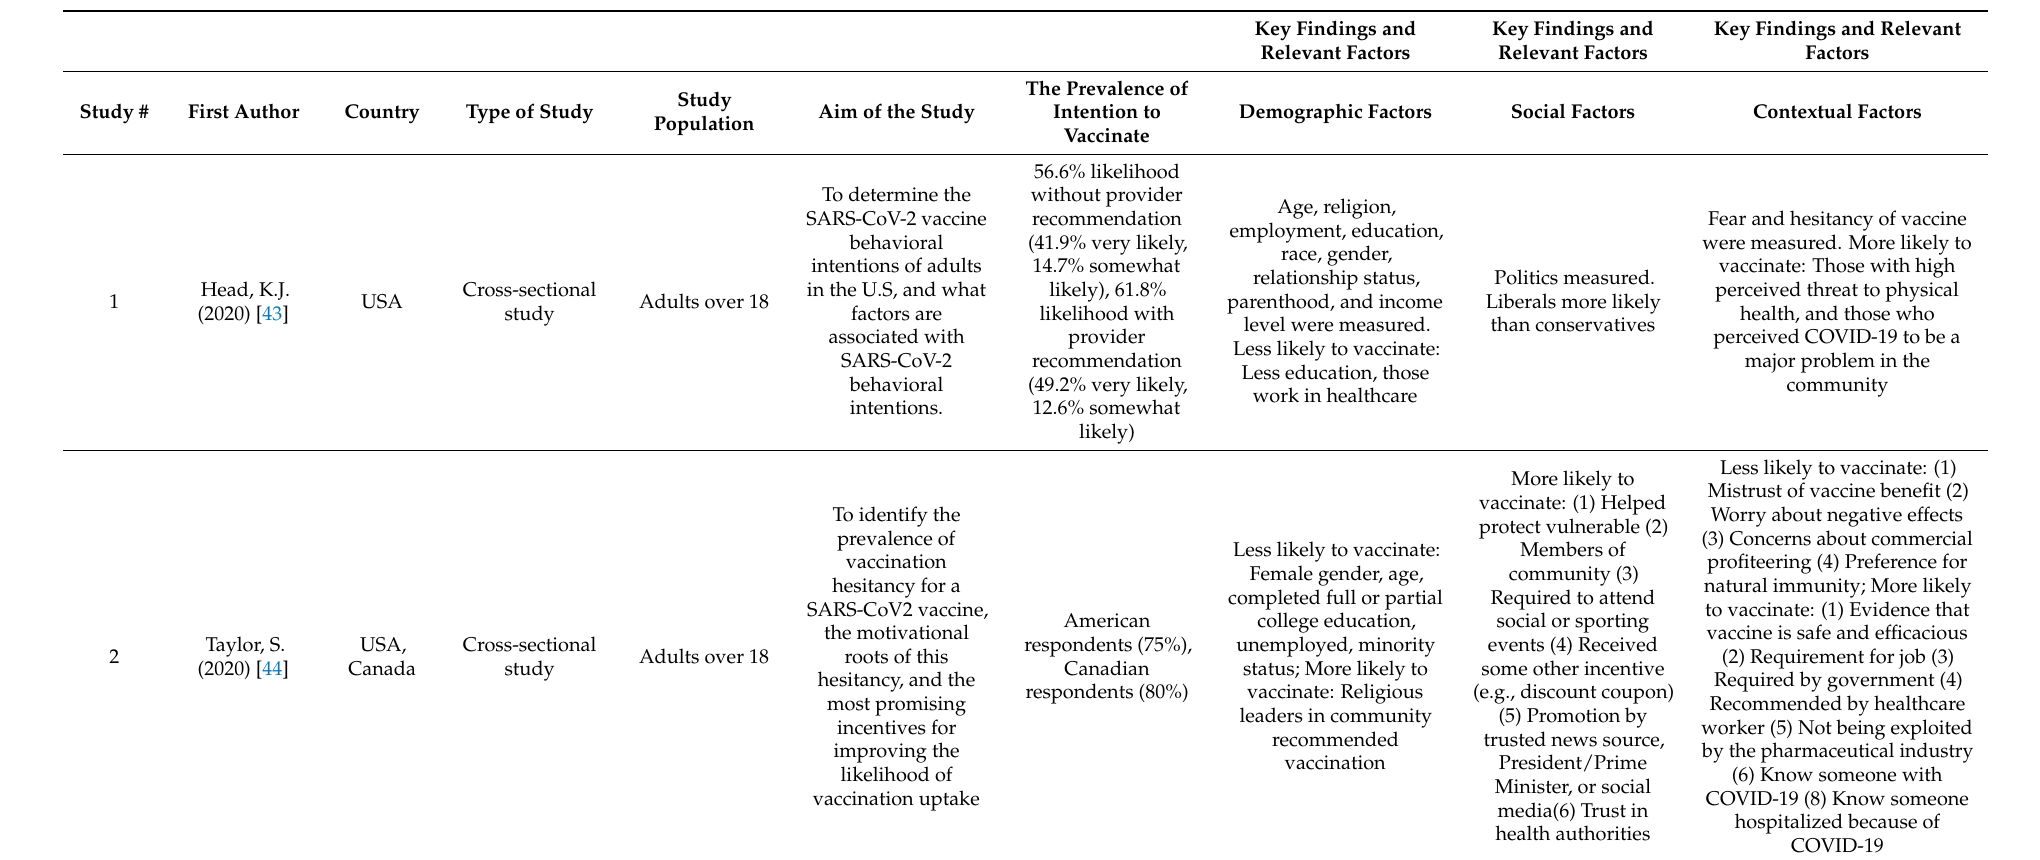
Table 1. Data extraction table for the